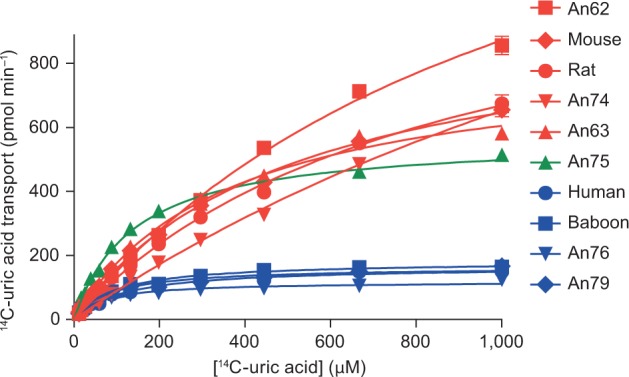
Uric acid transport kinetics of ancestral and extant URAT1 transporters. Assays were done as described in figure 1. High-affinity/low-capacity transporters, similar to hURAT1, are shown in blue. Low-affinity/high-capacity transporters, similar to r/mURAT1, are shown in red. The high-affinity/high-capacity transporter An75 is shown in green.